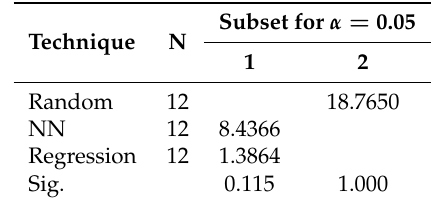
Table 6. Duncan: Homogonous Error rate subset.